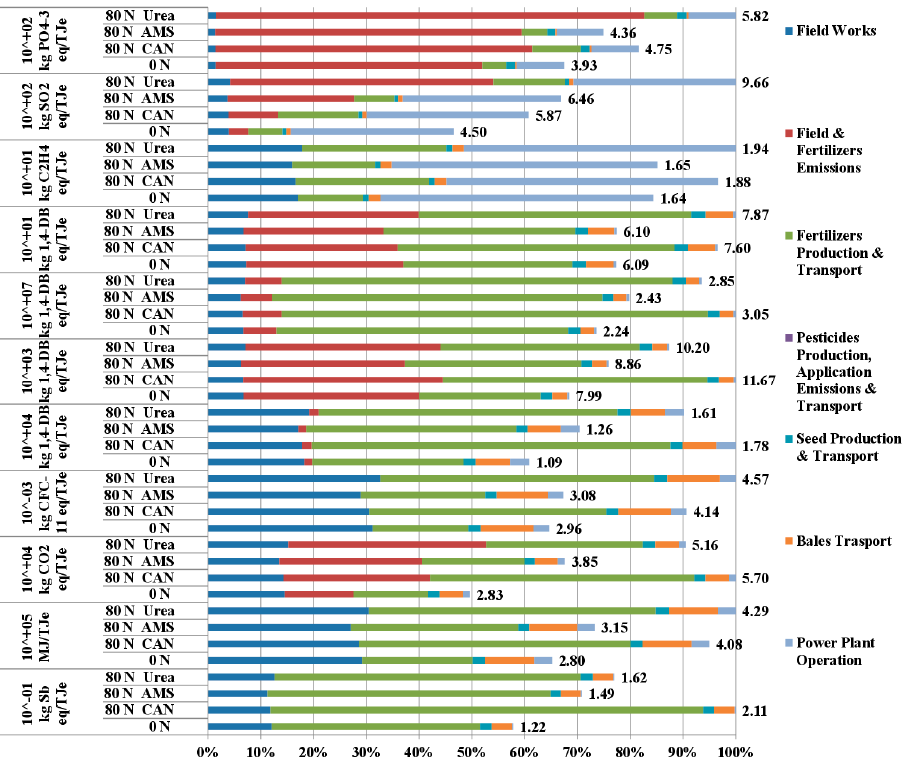
Figure A3. Corner-Middle-Layer (CML) method impacts by phases considered in the life cycle assessment of rye energy crops when producing 1 TJe under four different fertilizer regimes. AMS: ammonium sulphate, CAN: calcium ammonium nitrate. Nitrogen fertilizers aplication rates at the y -axis are in kg/ha. The percentages of the x -axis represent the relative contribution of each one of the four fertilizer alternatives studied with respect to the one which produced the highest impacts (100%).